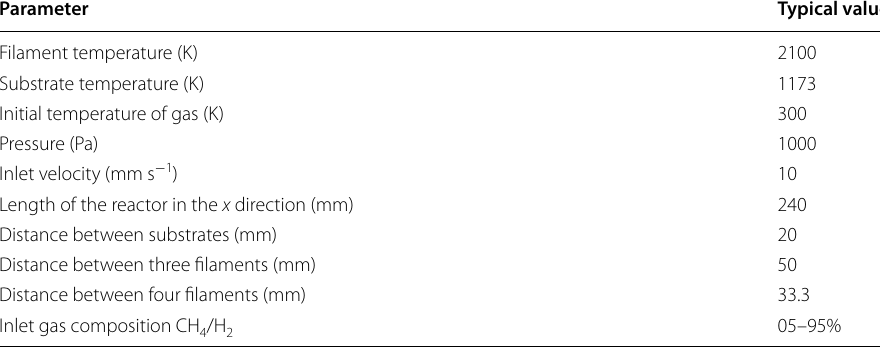
Fig. 1 Simplified scheme of the HFCVD reactor